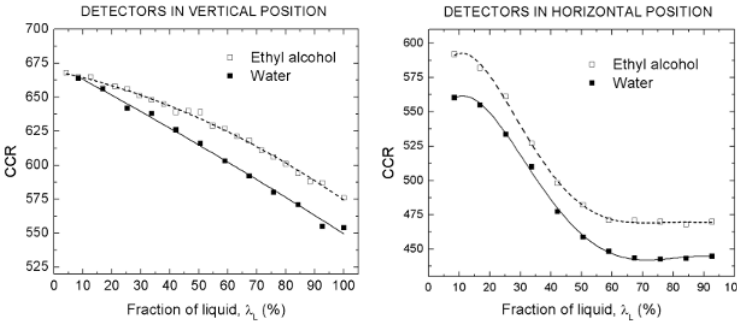
Figure 3. CCR for two-phase fluids (air-water and air-ethyl alcohol) with different fractions of liquid when detectors are in vertical (left) and in horizontal (right) position. Uncertainties of the CCR are 2